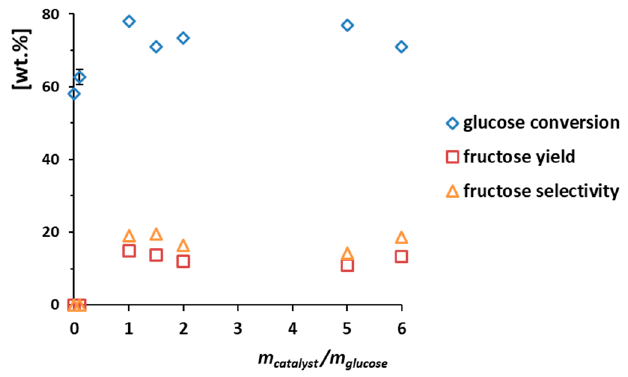
Figure 8. Glucose conversions and fructose yields of the calcinated hydrolysate from lignocellulose with a varying mass ratio of hydrotalcite catalyst to glucose; pretreatment parameters: beech wood, T = 180 ◦ C, 0.05 mol / L H 2 SO 4 ; isomerization parameters: c glucose = 2.5 g / L, air atmosphere, T = 100 ◦ C, t = 60 min, pH = 1.3.